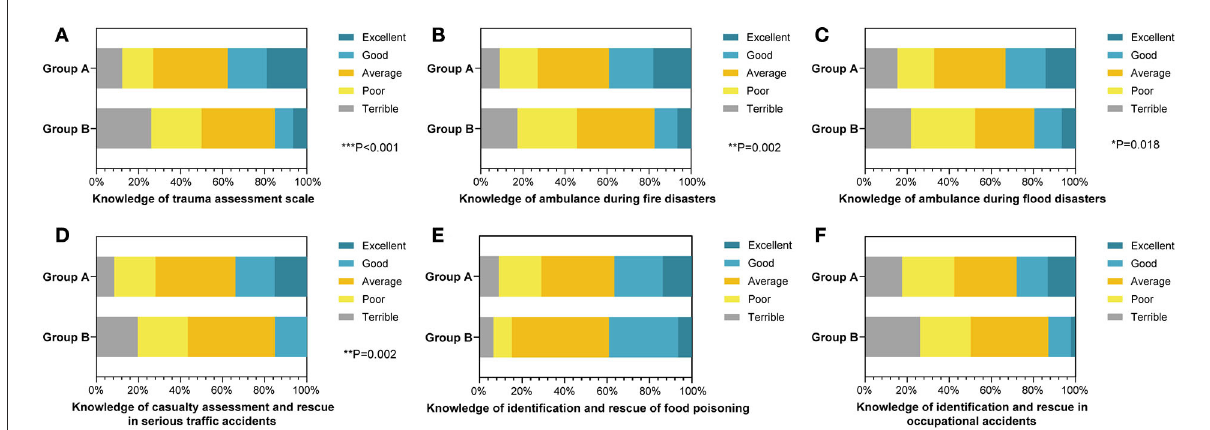
FIGURE2 The percentage stacking histograms of the comparison in the knowledge of noncommunicable diseases associated with public health emergency (PHE) between clinical and preventive medicine students with a 5-point Likert scale. (A) The knowledge of trauma assessment scale between clinical and preventive medicine students. (B) The knowledge of ambulances during fire disasters between clinical and preventive medicine students. (C) The knowledge of ambulances during flood disasters between clinical and preventive medicine students. (D) The knowledge of casualty assessment and rescue in serious traffic accidents between clinical and preventive medicine students. (E) The knowledge of identification and rescue of food poisoning between clinical and preventive medical students. (F) The knowledge of identification and rescue in occupational accidents between clinical and preventive medical students. The nonparametric test was applied for the comparison (The number of group A is n1 = 189; the number of group B is n2 =